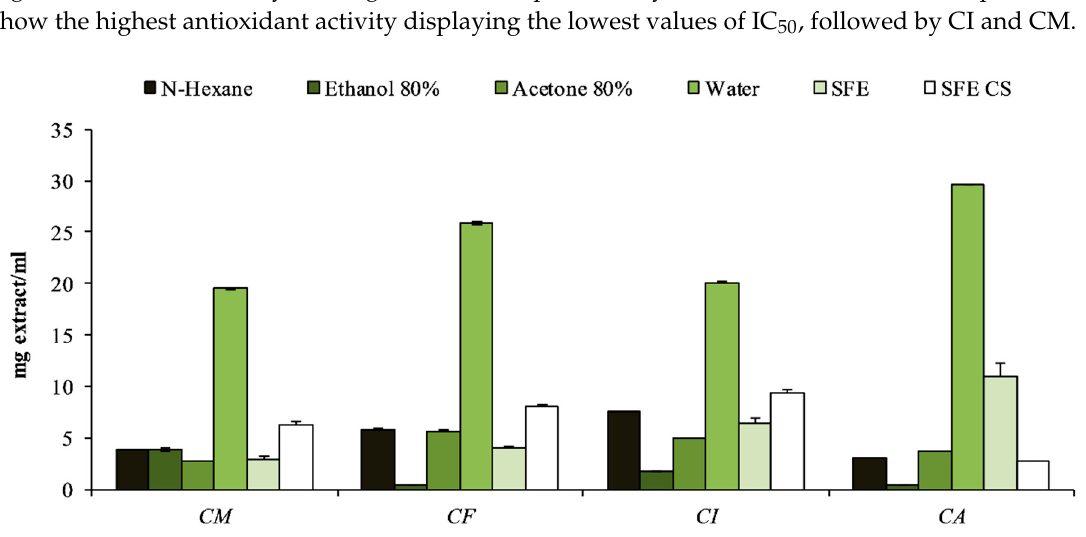
Figure 3. DPPH radical scavenging activity (IC 50, mg/mL) determined in extracts obtained from dried leaves of different Calendula species (CM: C. maritima ; CF : C. fulgida ; CI: C. hybrid ( maritima × fulgida ); CA : C. arvensis ), with different solvents (Results of the statistical analysis are shown in Supplementary Table S3).